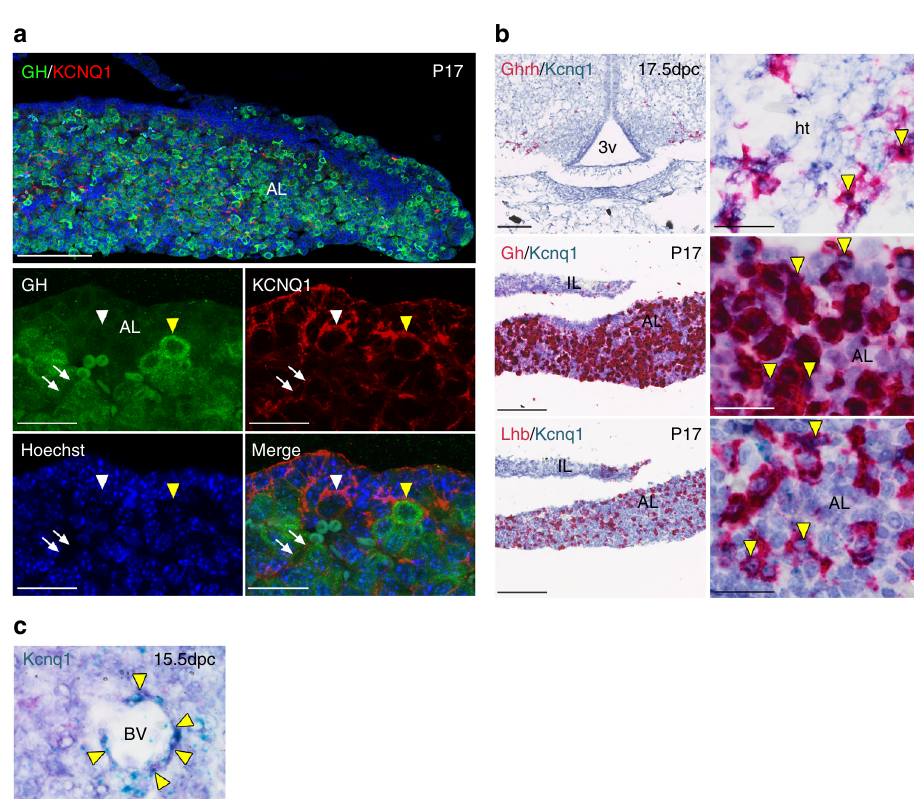
Fig. 3 KCNQ1 is expressed in cells of the mouse hypothalamic – pituitary growth hormone axis. a Immuno fl uorescence staining against KCNQ1 (red) and Growth Hormone (GH, green) reveals membranous expression of KCNQ1 in a subset of GH-expressing cells of the postnatal pituitary at day 17 (P17, yellow arrowhead) as well as expression in additional pituitary cell types (white arrowhead) and surrounding blood vessels (arrows). b Sensitive RNAscope in situ hybridization detects Kcnq1 mRNA (aqua) in Ghrh -expressing neurons of the developing hypothalamus (red) at 17.5 days post coitum (dpc), and con fi rms the expression in Gh -expressing somatotropes (red) at P17. Kcnq1 is expressed in additional endocrine cells types such as Lhb -expressing gonadotropes (red). Examples of double-positive cells are noted by yellow arrowheads. c Kcnq1 mRNA is detected in cells surrounding blood vessels of the developing anterior pituitary at 15.5 dpc. Scalebars indicate 100 μ m in low magni fi cation images and 20 μ m in high magni fi cation images. AL anterior lobe, BV blood vessel, Ht hypothalamus, IL intermediate lobe, 3v third